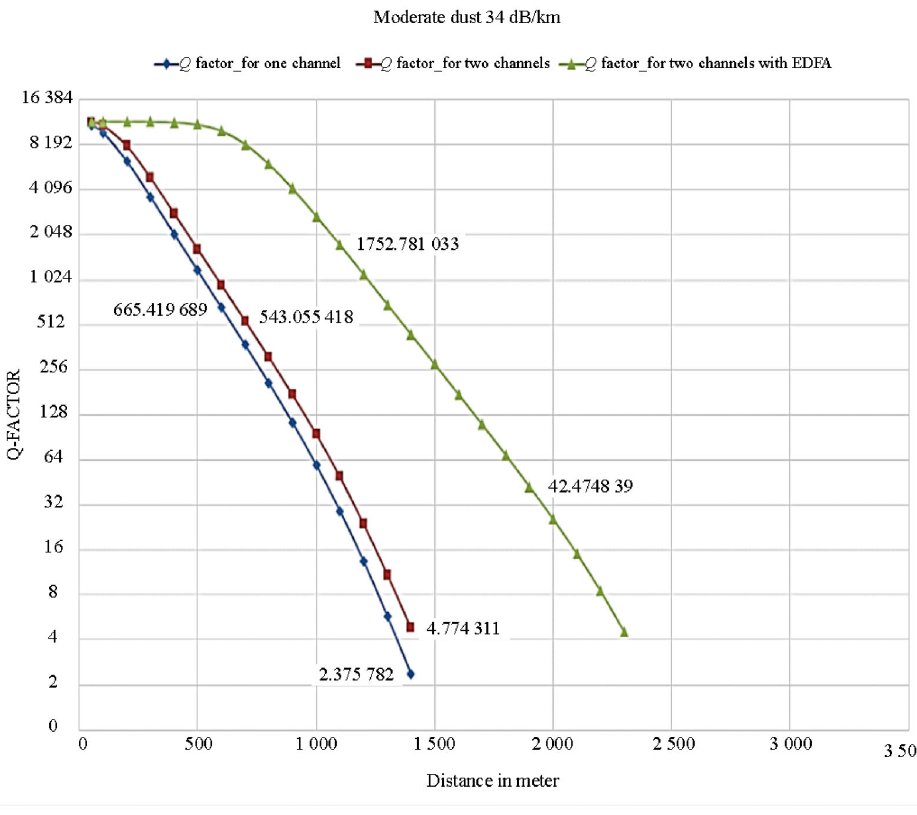
Fig. 6 Quality factor at 34 dB/km according to the